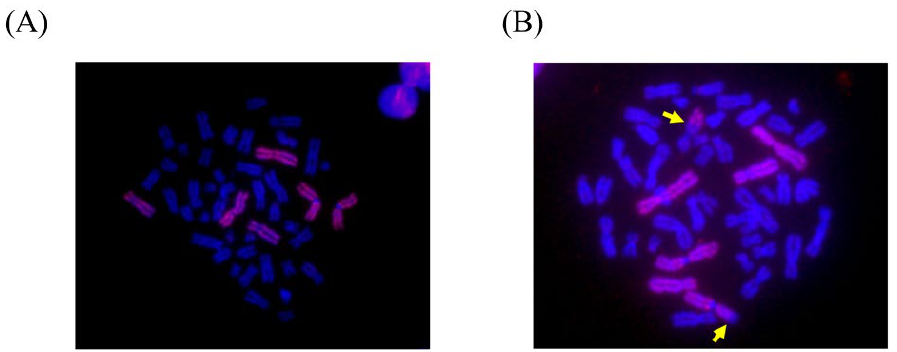
Figure 1. Stable chromosome translocation based on fluorescence in situ hybridization (FISH) in the microscope. ( A ), Normal; ( B ) translocation.